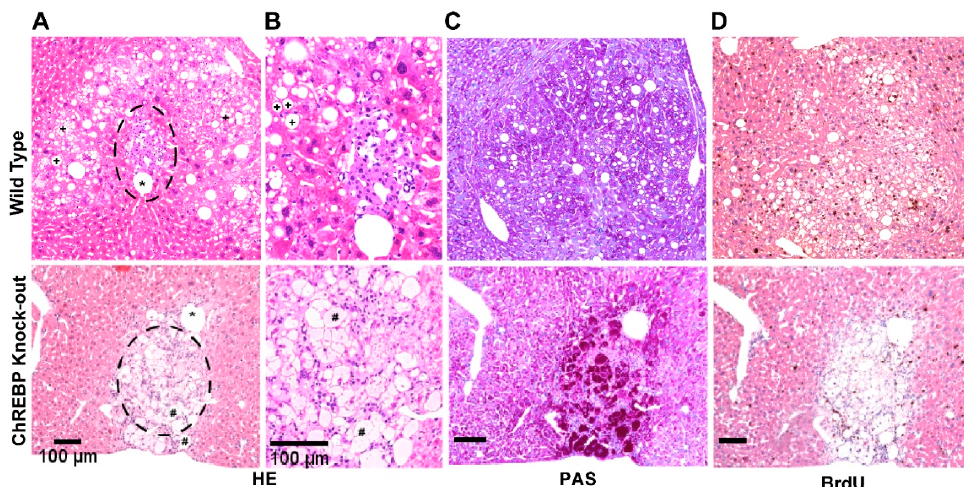
Figure 1. WT and KO CCF display distinct morphological alterations. Representative histological and immunohistochemical images showing CCF of altered hepatocytes in wild type (upper panel) and ChREBP-knockout (lower panel) mice after six months. CCF in WT mice revealed lipid droplets (indicated by ‘+’ symbol), which were instead lacking in CCF from KO mice. A transplanted pancreatic islet located in the middle of the WT CCF is illustrated with dashed circle ( A ) and ( B ) designates a typical CCF that corresponds to high PAS reactivity. Asterisk (*) represents portal vein branch, and hash symbols (#) indicate enlarged and swollen hepatocytes ( A , B ). PAS reaction was stronger in KO-CCF than in WT-CCF ( C ). Proliferative activity, as assessed by BrdU-LI, was markedly higher in CCF of WT mice compared to KO mice ( D ). Length of the lower edge (0.8 mm) ( A – D ). Higher magnification (0.3 mm) ( B ).